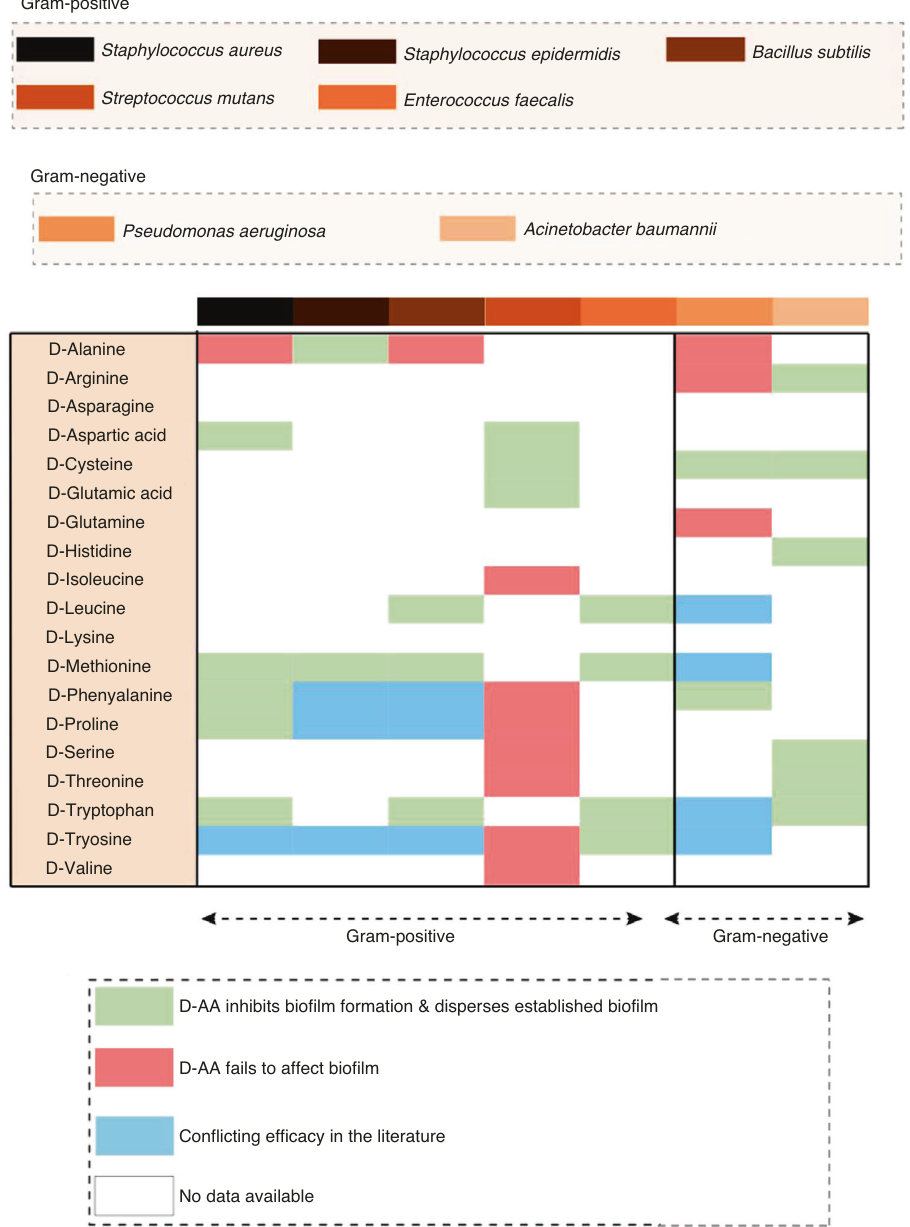
Fig. 4 A comparative heatmap of data compiled from the literature showing the various gram-positive and gram-negative microorganisms associated with PJI and the ef fi cacy of D-AAs to inhibit pathogenic bio fi lm formation and/or augment the disassembly of mature bio fi lms. Variability in the response to D-AAs for both gram-positive and gram-negative species was found. For example, all studies reported thus far have shown D-AA ef fi cacy against A. baumannii bio fi lms; however, many of the D-AAs investigated against S. mutans were reported to be